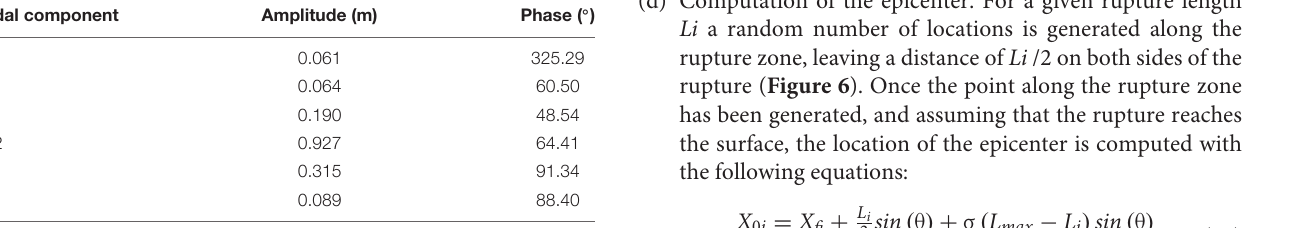
TABLE 1 | Main components (amplitude and phase) in Bonanza. Tidal